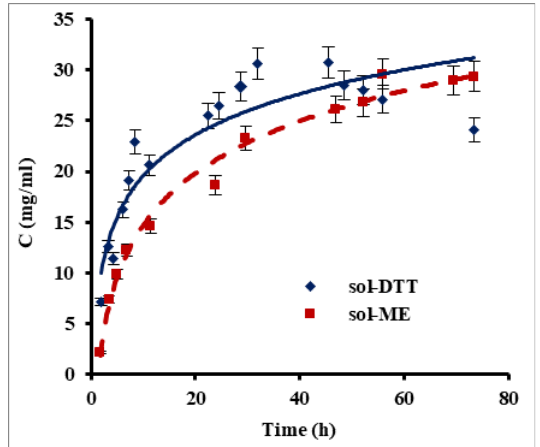
Figure 1. Protein extraction from human hair using β -mercaptoethanol (sol-ME) and 1,4-dithiothreitol (sol-DTT) containing solutions. Protein was extracted at 50 °C from delipidized human hair. Protein concentration was measured by the Bradford assay. Error bars present standard errors.